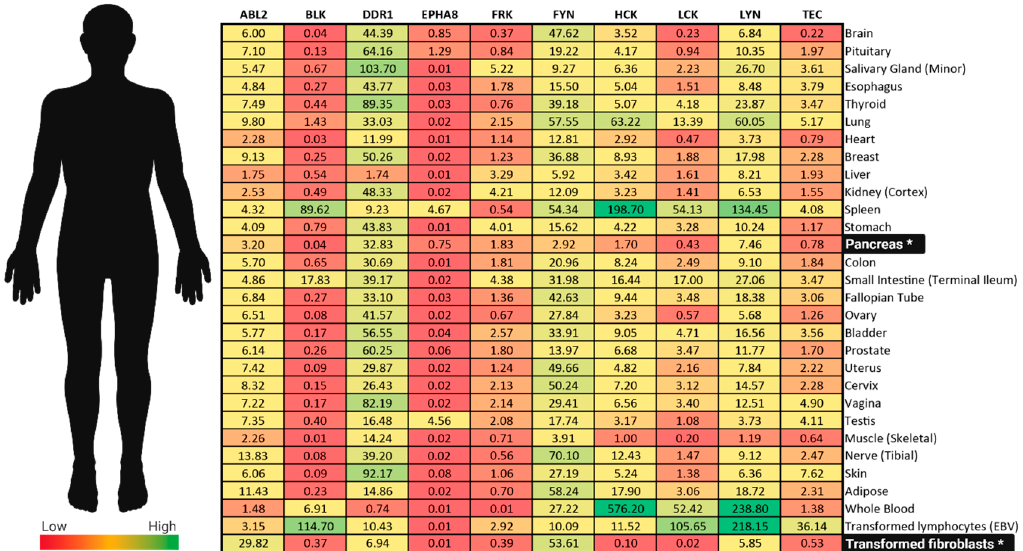
Figure 2. Kinase tissue distributions. The Genotype-Tissue Expression (GTEx) database was queried for all kinases of interest including Fyn-related kinase (FRK); B lymphoid kinase (BLK); hemopoietic cell kinase (HCK); ABL proto-oncogene 2 kinase (ABL2); discoidin domain receptor 1 kinase (DDR1); Lck/Yes-related novel kinase (LYN); ephrin receptor A8 kinase (EPHA8); FYN proto-oncogene kinase (FYN); lymphocyte cell-specific kinase (LCK); tec protein kinase (TEC)). Average median transcripts per million (TPM) were calculated for adipose, brain, cervix, colon, esophagus, heart, and skin subcategories. Asterisks (*) indicate key data relating to pancreatic ductal adenocarcinoma (PDAC). Samples collected from nondiseased tissue.